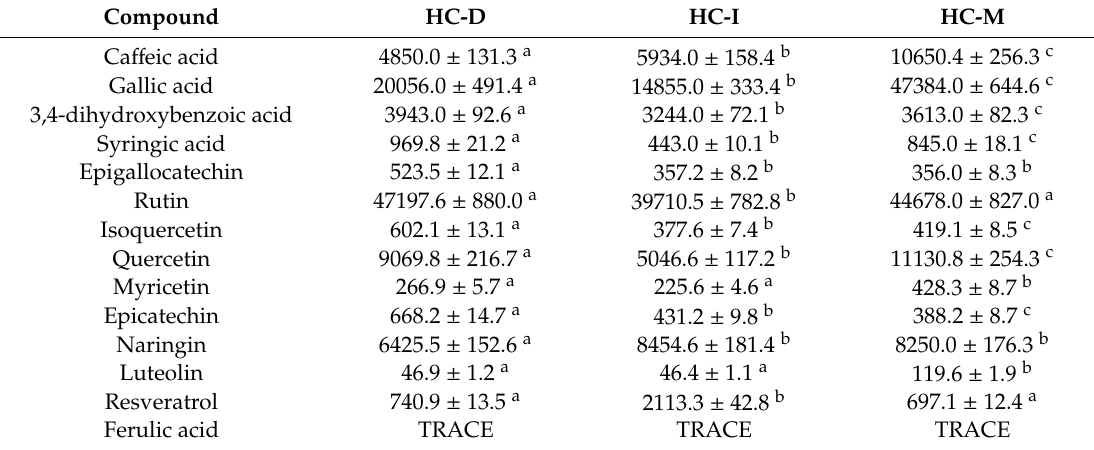
Table3. Phenoliccompounds(mg / kg)in H.crepitans extracts. Datarepresentthemean values ± SDfrom two separate experiments, each performed in triplicate. One-way ANOVA followed by Tukey–Kramer post-hoc analysis was used, and di ff erences were considered significant when p < 0.05 and are indicated with di ff erent superscripts letters: for values with a di ff erent letter, the di ff erence is statistically significant ( p <